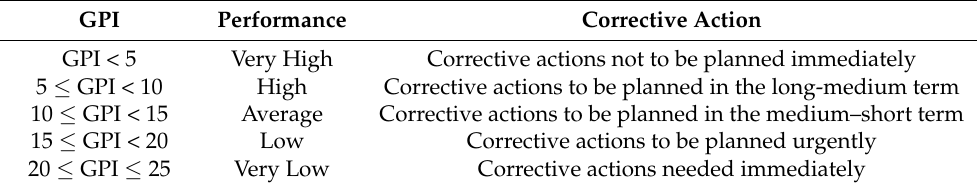
Table 1. Global Performance Index—GPI values and Performance